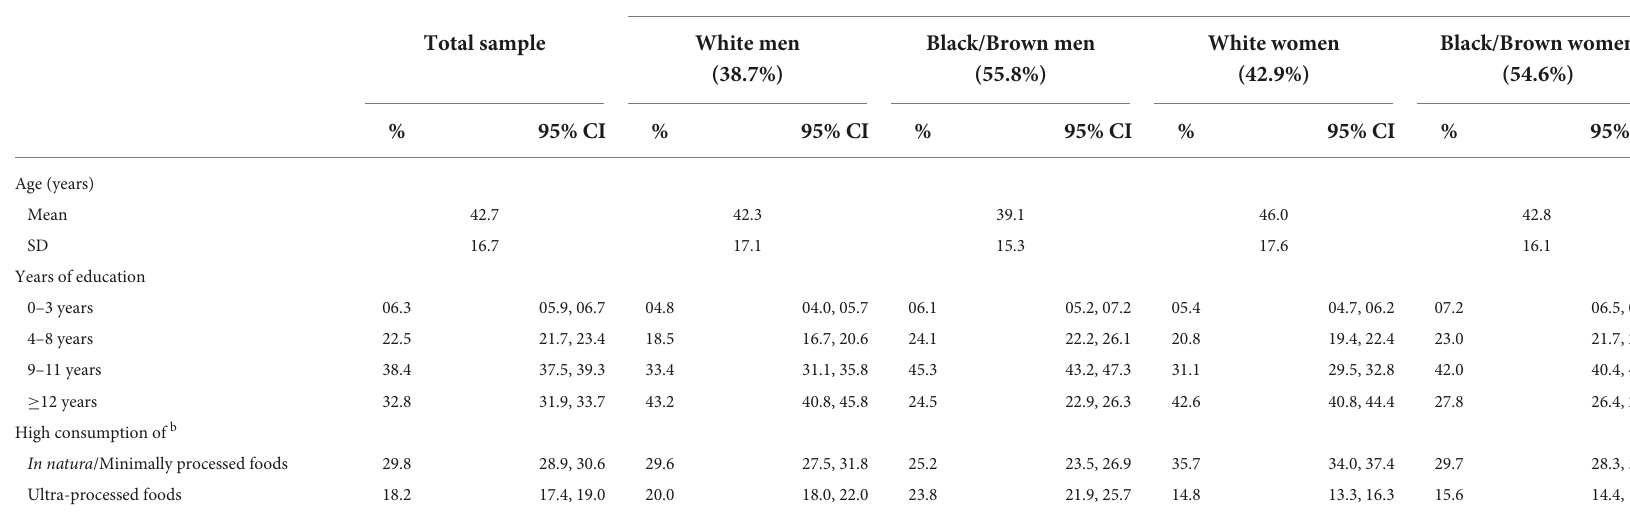
General characteristics of the